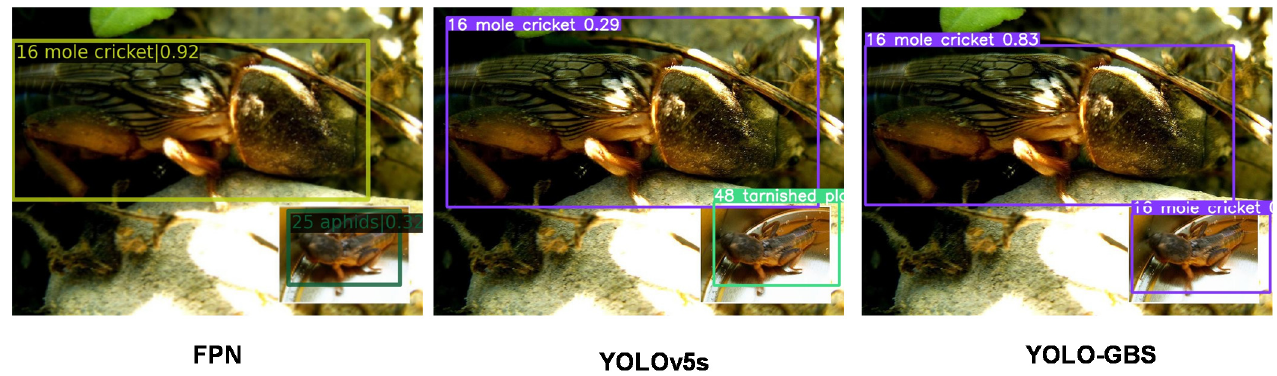
Figure 10. YOLOv5s did not detect the insect in the figure.